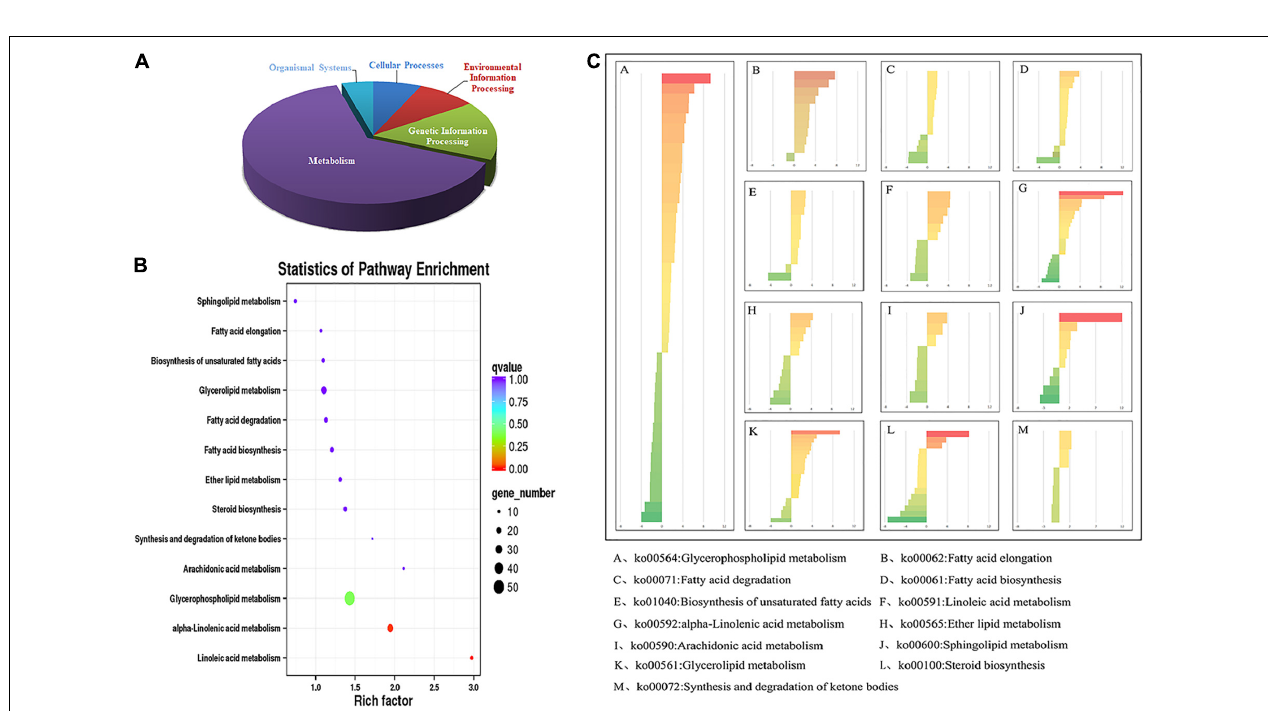
FIGURE 3 | Lipid-related DEGs annotated in KEGG pathways under cold stress (5 ◦ C). DEGs, differentially expressed genes; KEGG, Kyoto Encyclopedia of Genes and Genomes. (A) The distribution of metabolism-related DEGs identified in the maize roots transcriptome; (B) the statistics of KEGG pathway enrichment of DEGs related to lipid metabolism; (C) the DEGs involved in different lipid metabolic pathways. The number of the genes in each category were displayed on the x -axis.